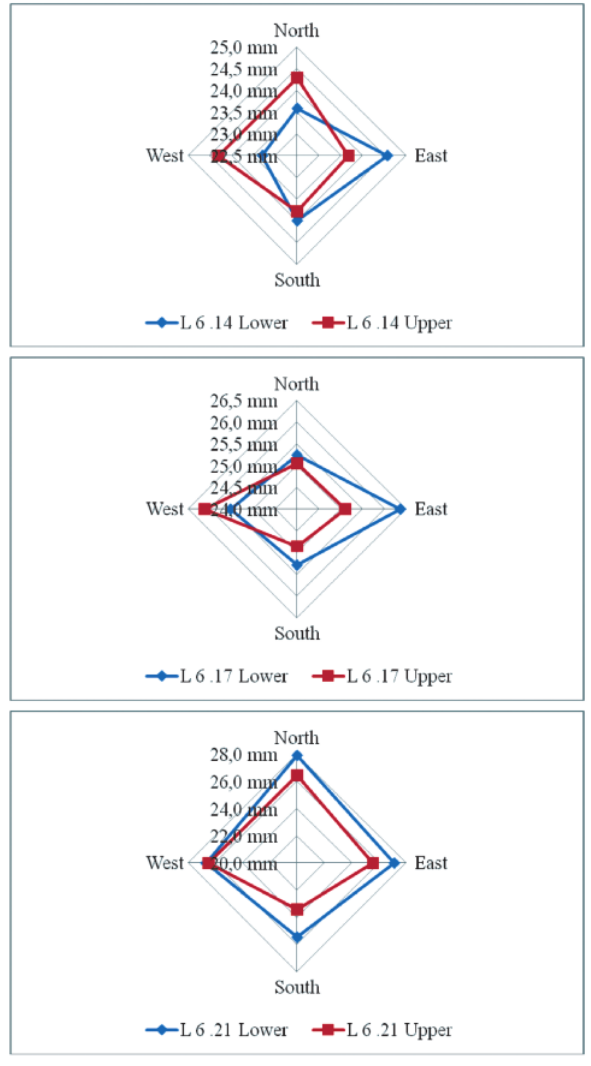
Fig. 4: The width in the function of time, orientation and height in the case of Germersdorfi